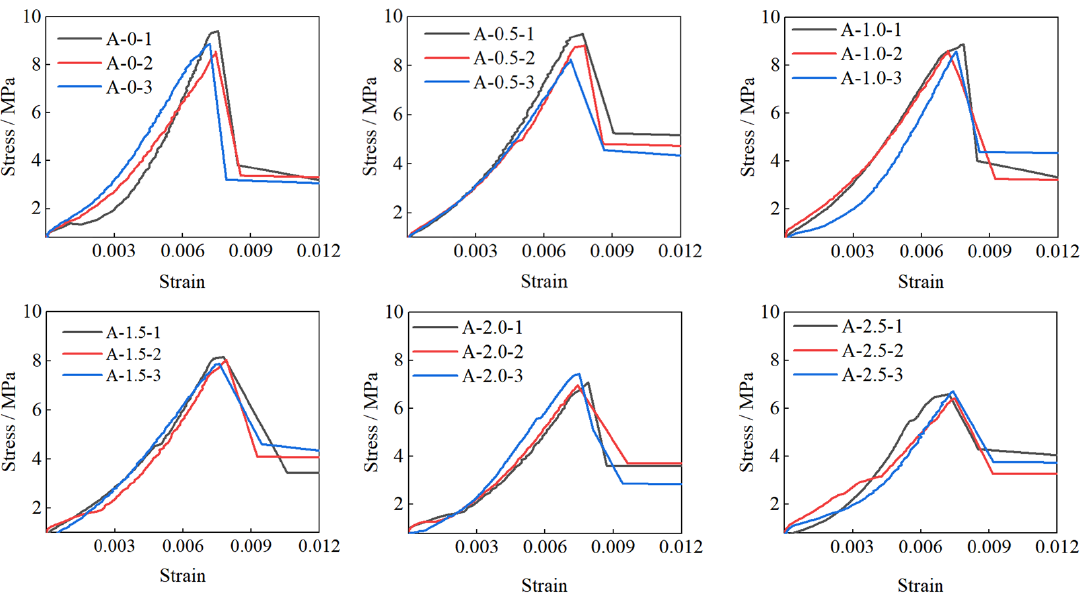
Figure 9. Stress-strain relationship curve of concave hexagonal unit cell specimen.